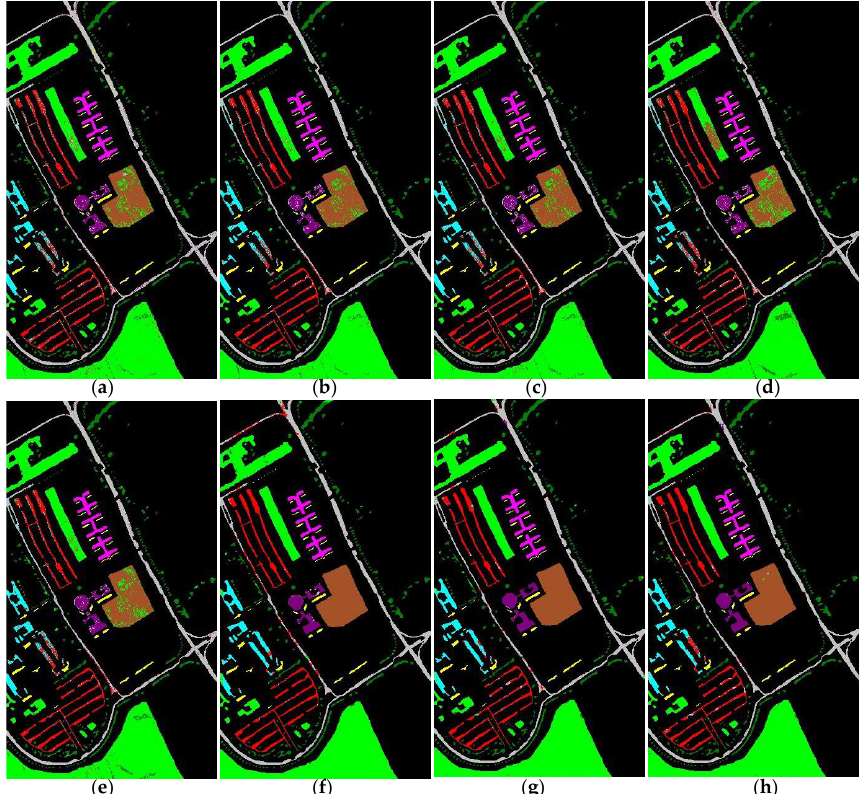
Figure 12. Classification maps for the University of Pavia dataset obtained by SVM classification after